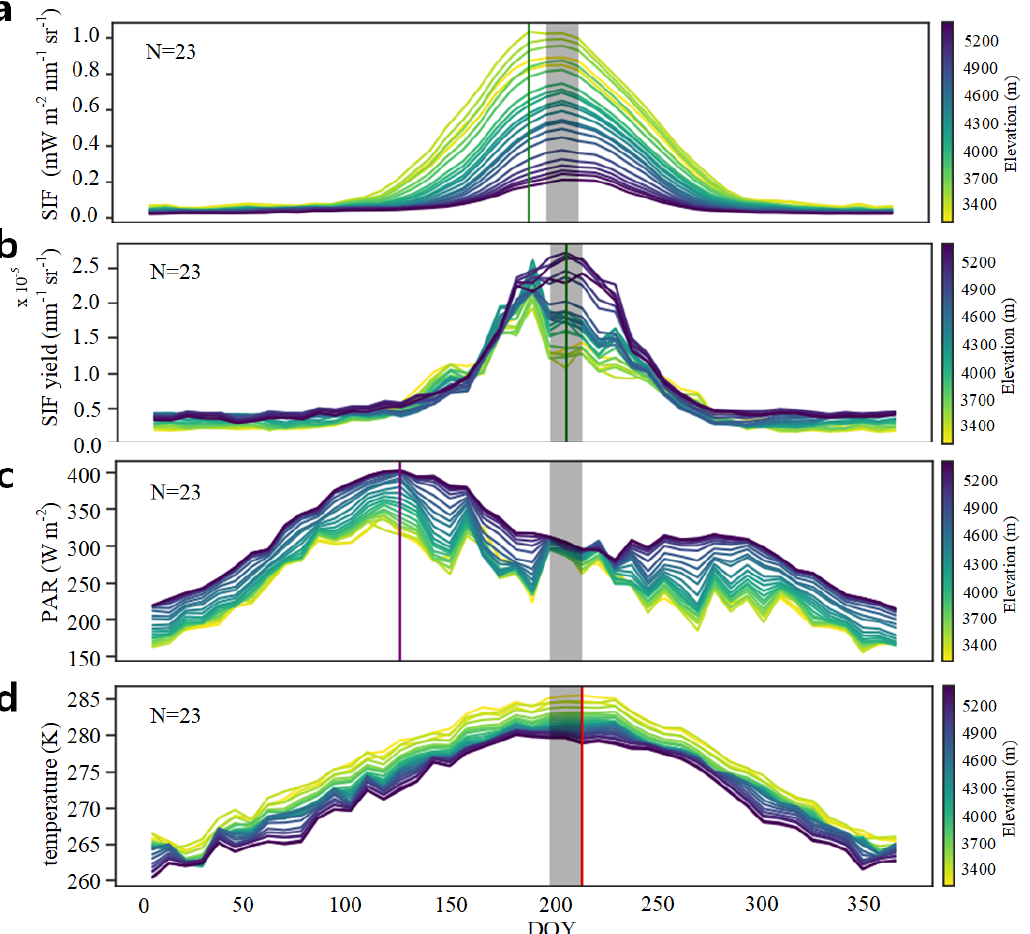
Figure 3. Seasonal variations in ( a ) SIF , ( b ) SIF yield , ( c ) photosynthetically active radiation (PAR), and ( d ) temperature at different elevations. Lines in each subgraph indicate DOY when variables reach their peaks, and gray rectangles indicate (cid:1845)(cid:1835)(cid:1832) (cid:1877)(cid:1861)(cid:1857)(cid:1864)(cid:1856) peak time for comparison.